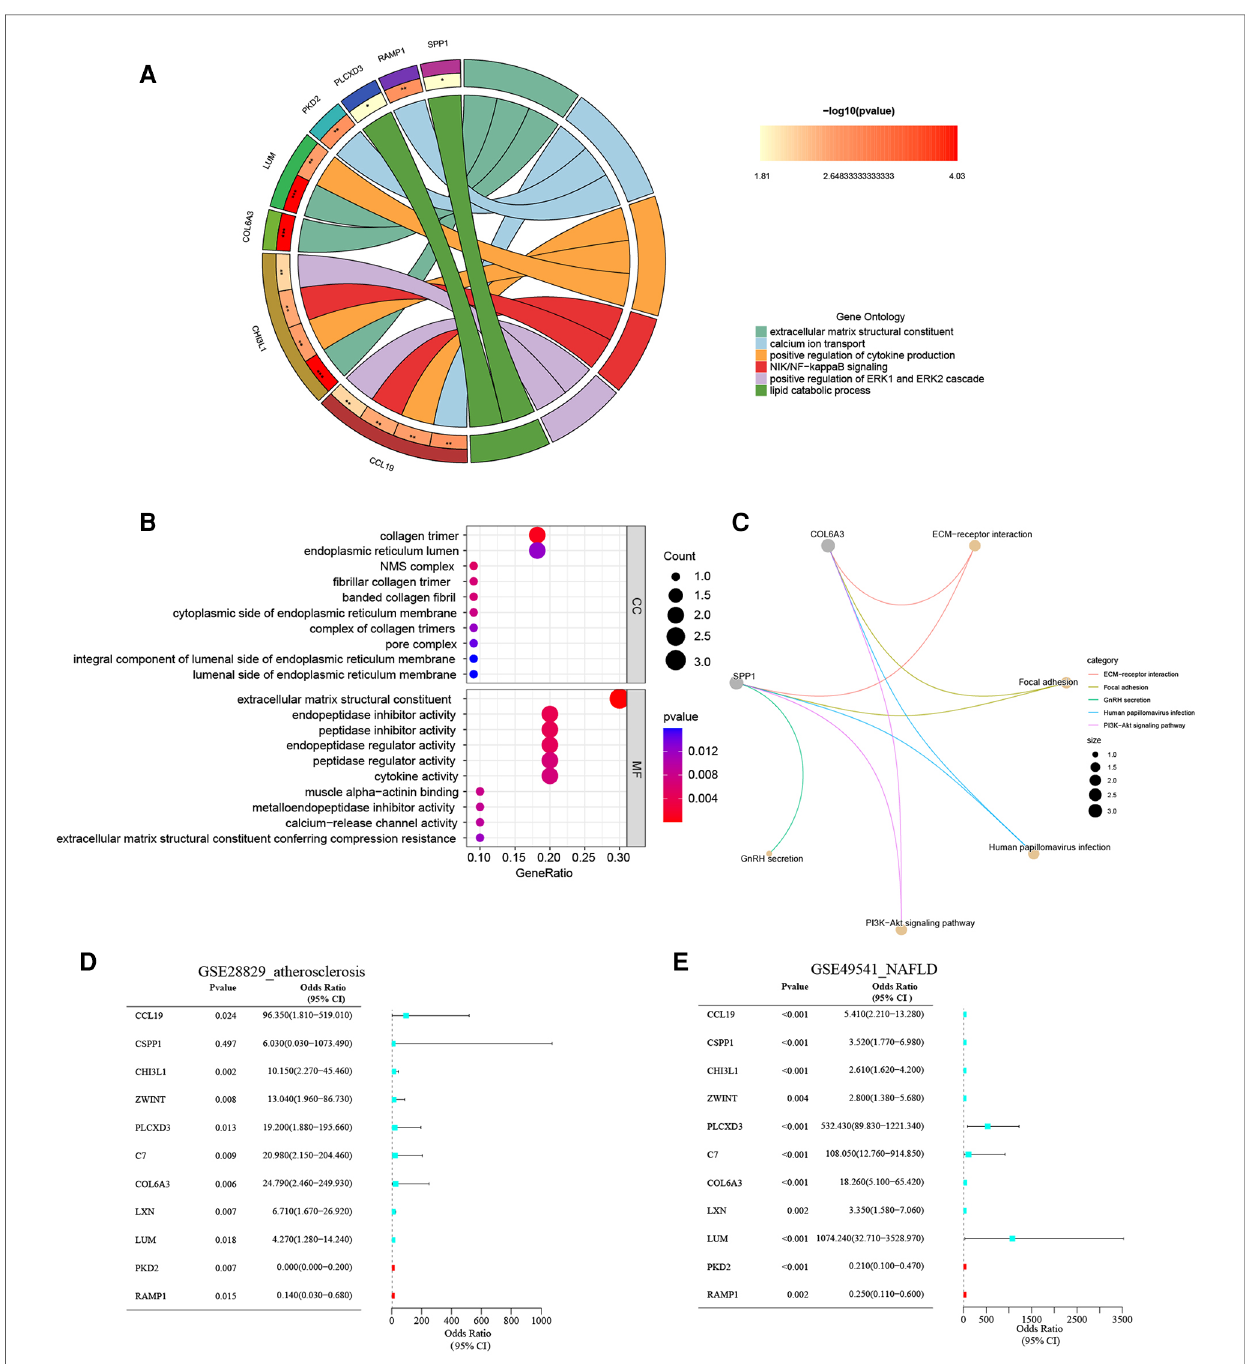
FIGURE 4 ( A ) The chord plot show GO BP enrichment signi fi cance items of co-DEGs; ( B ) the bubble chart show GO CC and GO MF enrichment signi fi cance items of co-DEGs; ( C ) the KEGG pathway enrichment analysis of co-DEGs; ( D ) forest map of univariate logistic regression of co-DEGs in GSE28829; ( E ) forest map of univariate logistic regression of co-DEGs in